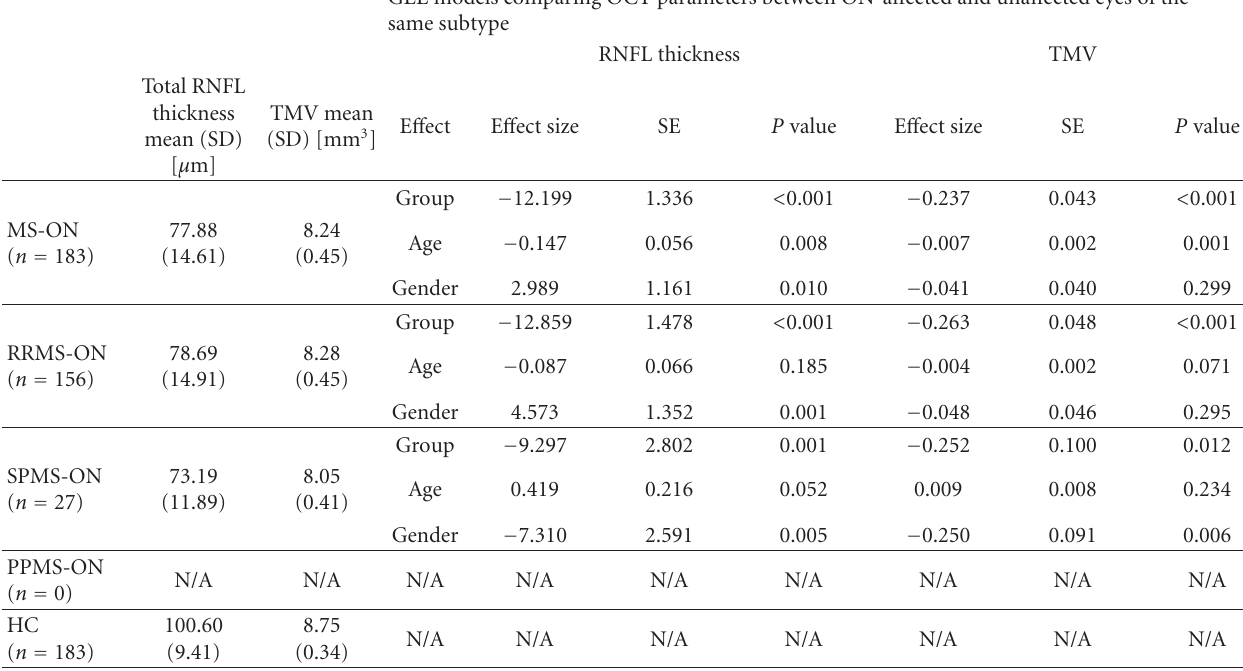
Table 3: OCT results for the subtypes of MS patients with a history of optic neuritis (ON). Total retinal nerve fiber layer (RNFL) thickness (in µ m) and total macular volume (TMV in mm 3 ) are given as mean values with standard deviation (SD). ON eyes were compared to ON- non a ff ected eyes of the same MS subtype using generalized estimation equation (GEE) models. GEE models estimate the e ff ect size with standard error (SE) and the respective P value.